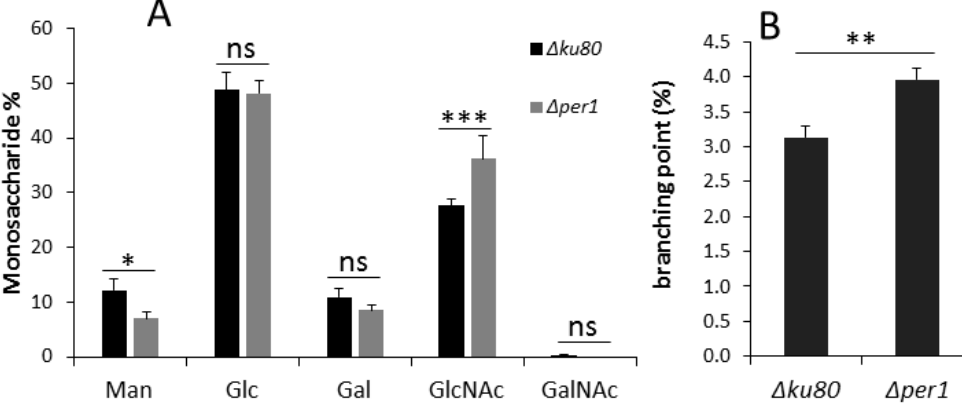
Figure 6. Analysis of the cell wall alkali-insoluble fraction. ( A ) Monosaccharide composition (Man, mannose; Glc, glucose; Gal, galactose; GlcNAc, N -acetylglucosamine; GalNAc, N -acetylgalactosamine); ( B ) percentage of branching of β -1,3-glucan. (values are the mean and standard deviation of three different experiments, statistical difference are indicated by * p < 0.05; ** p < 0.01; *** p < 0.001; ns, non significative).